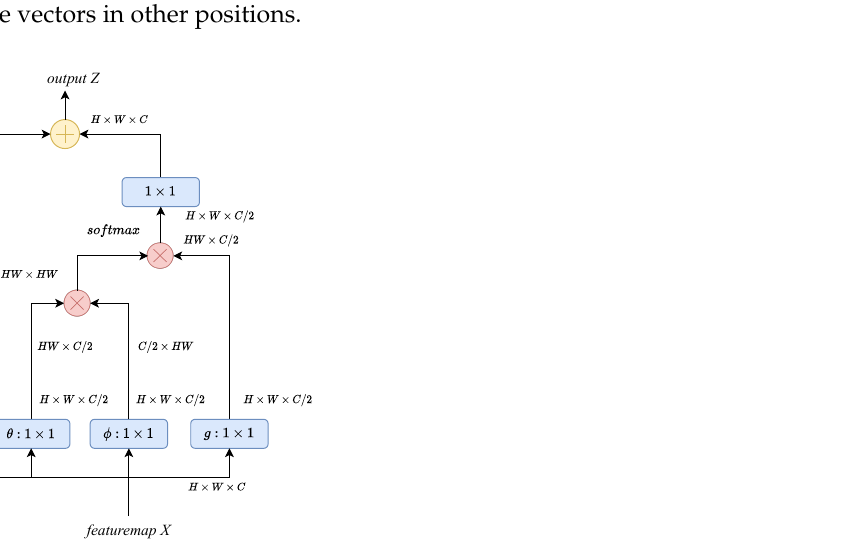
Figure 4. A space non-local block. H , W , and C stands for the height, width, and channel, respectively, of the feature map. The blue box stands for 1 × 1 convolution. “ ⊗ ” denotes matrix multiplication, and “ ⊕ ” denotes element-wise